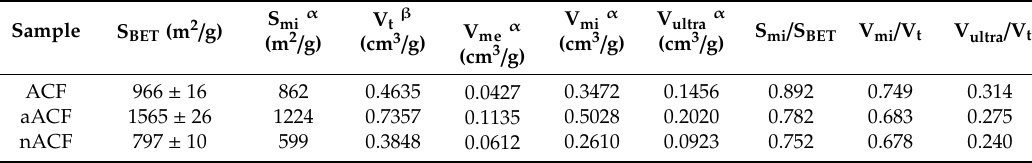
Table 1. Textural properties of the samples determined from the adsorption-desorption isotherms of N 2 at − 196 ◦ C.